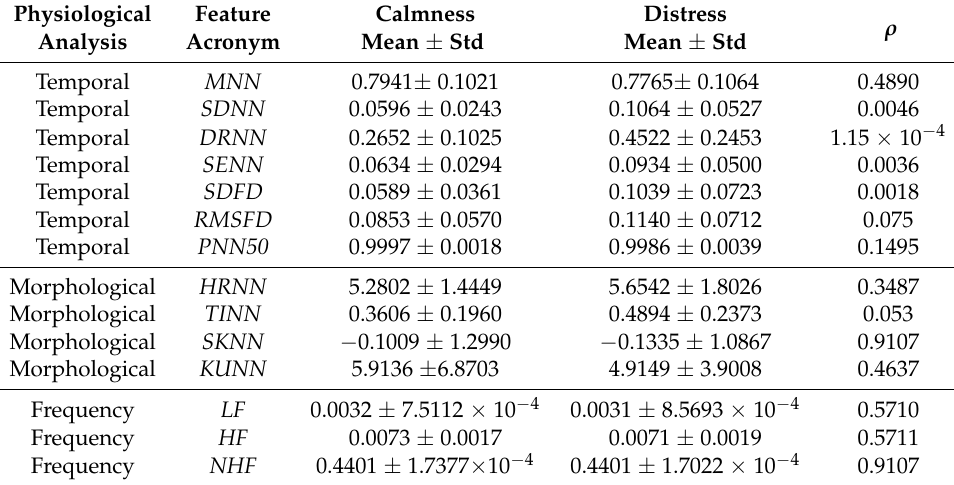
Table 2. Results obtained. Mean and std values for emotional states of calm and distress and statistical significance ( ρ ), for all parameters are